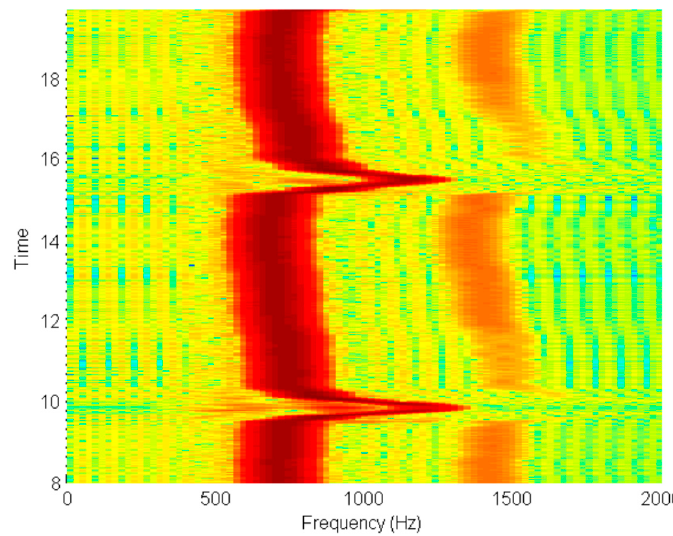
Figure 18. Received signal spectrogram of two consecutive forced breaths.